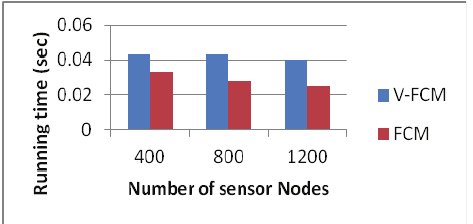
Fig: 5 Running time VS number of nodes Evaluation of running time by varying the number of cluster heads